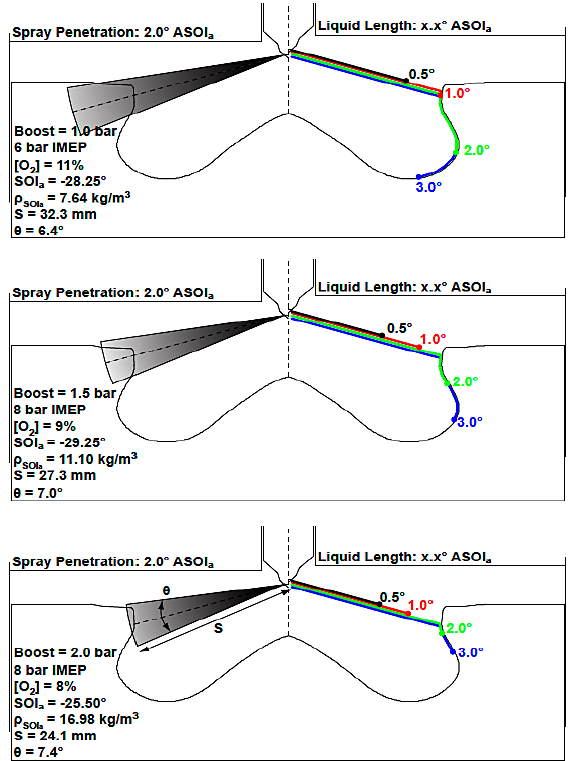
Figure 36. Schematics showing vapor penetration distances and dispersion angles in the left-hand column, and liquid length positions at certain times after the start of actual injection (ASOIa) in the right-hand column [40]. Table 10. Boost pressure effect of breakup time and